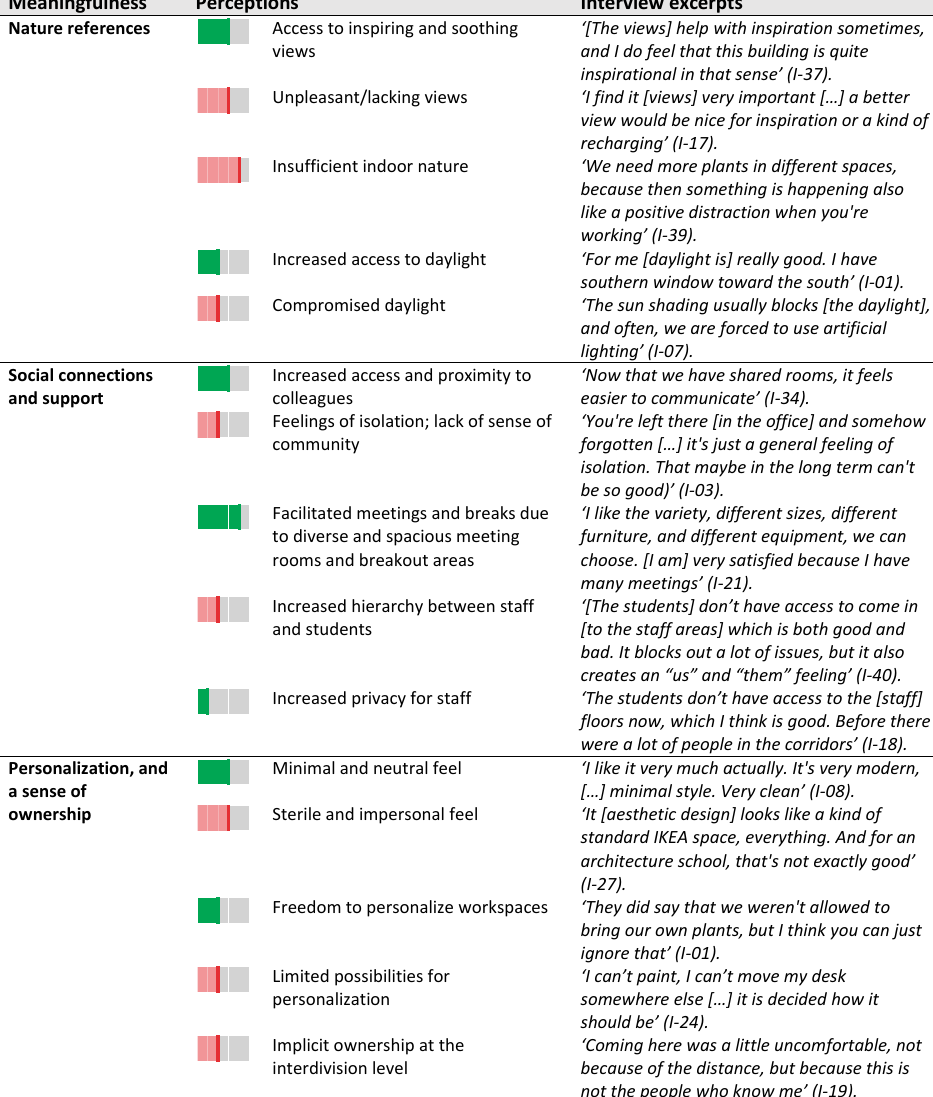
Figure 10. Perceptions of meaningfulness in the office environment as reported in